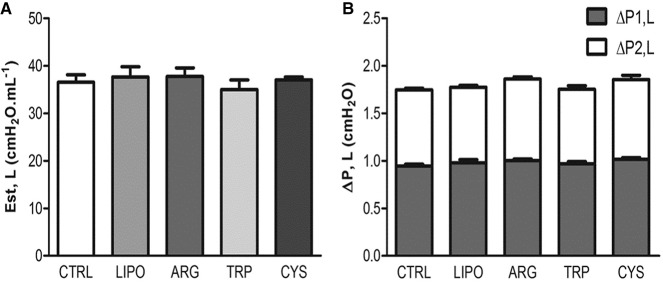
Effects of lipopolymers on lung function. Values are means ± SD of eight animals in each group (with 10 determinations per animal). Control group (CTRL) was instilled with vehicle, LIPO group was instilled with the lipopolymer only, and the ARG, TRP, and CYS groups were instilled with the lipopolymer containing l-arginine, l-tryptophan, and l-cysteine, respectively. (A) Lung static elastance (Est,L). (B) Stacked bar chart: the data in each gray bar represent the lung viscous pressure (ΔP1) and the white bars are viscoelastic/inhomogeneous (ΔP2) pressure dissipation. The whole column represents the total pressure (ΔPtot) variation in each group.